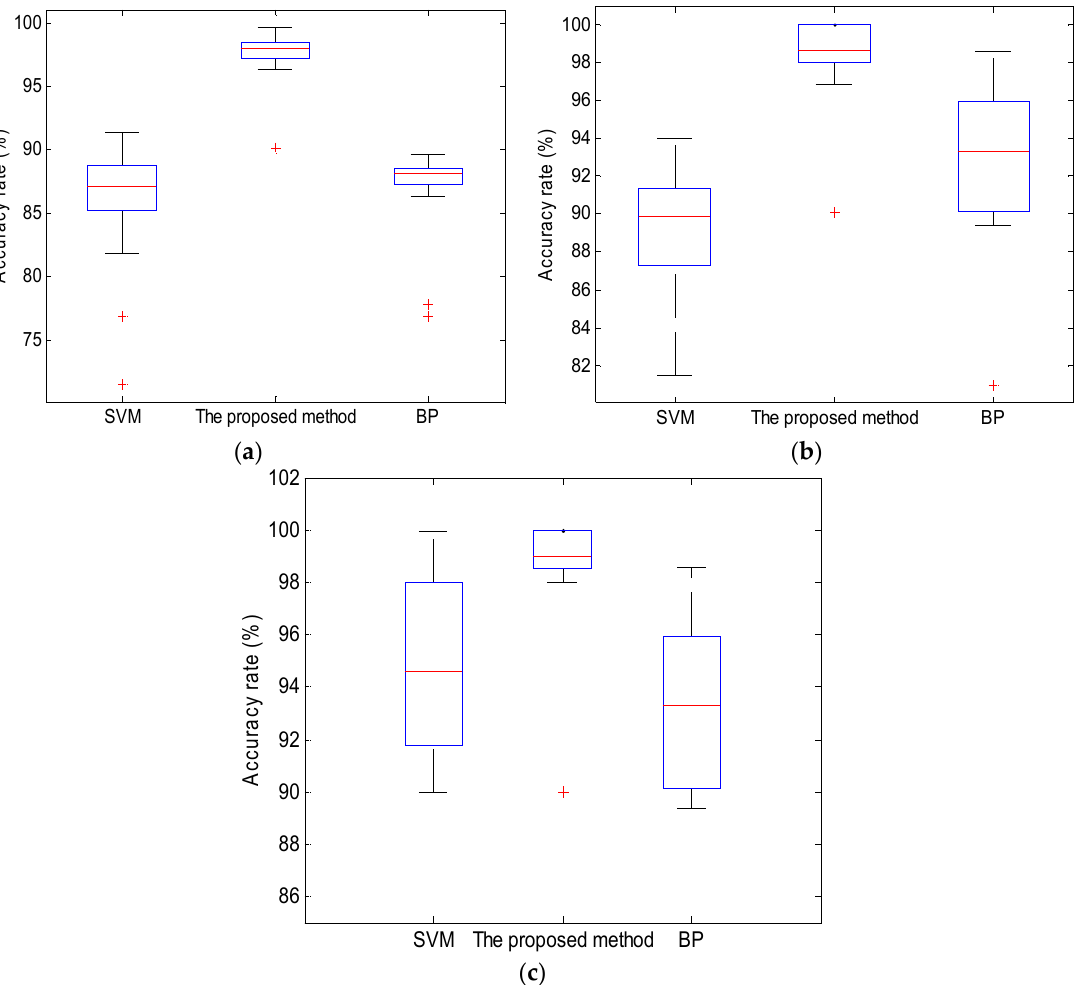
Figure 13. Test accuracy of classifiers: ( a ) for 1 mm leak; ( b ) for non-leak; and ( c ) for 2 mm leak.